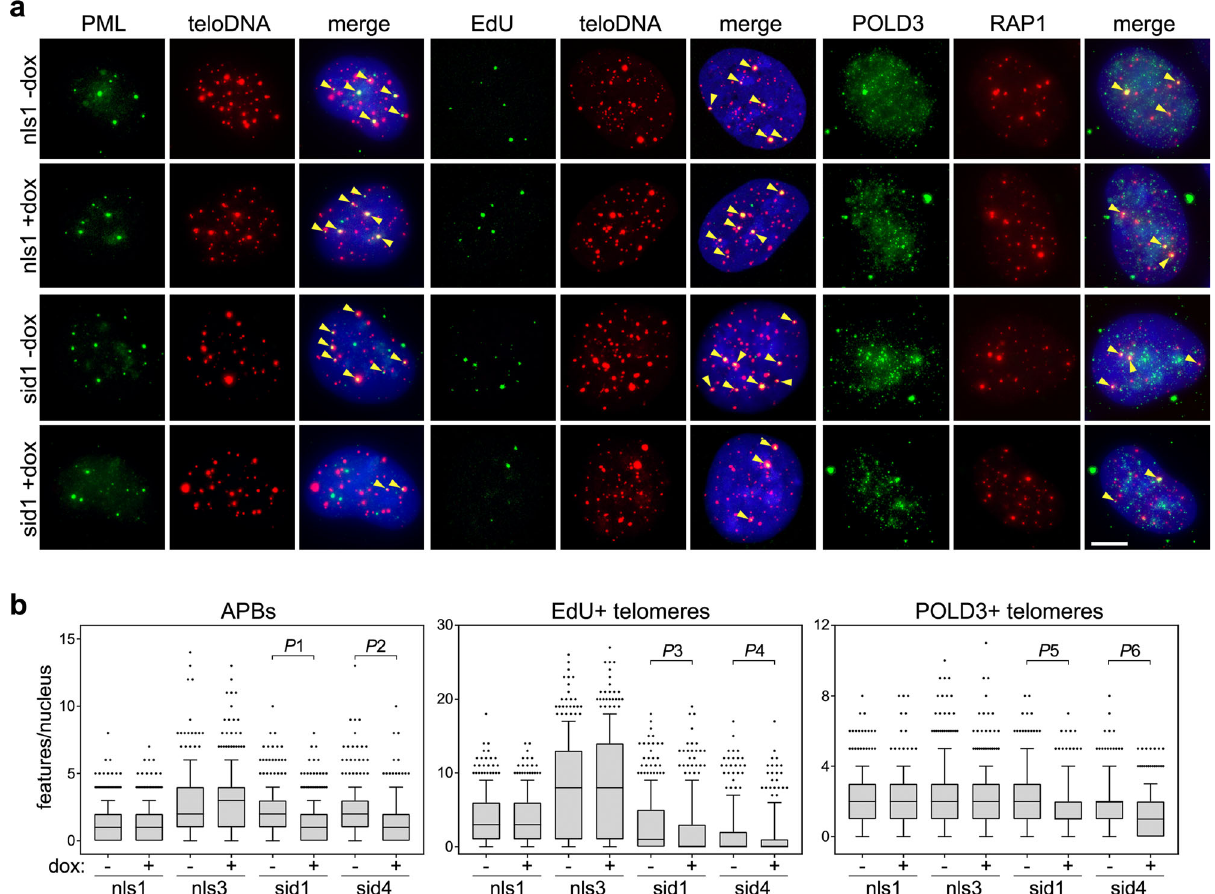
Fig. 3 TERRA transcription inhibition alleviates ALT activity. a Left and right panels: examples of PML or POLD3 IF (green) combined with telomeric DNA FISH (teloDNA) or RAP1 IF (red). Middle panels: examples of EdU detection (green) combined with telomeric DNA FISH (red). DAPI-stained DNA is in blue. The indicated cell lines were treated with dox for 24 h for PML or for 24.5 h for POLD3 and EdU (G2 synchronized cells, see methods for details). Arrowheads in the merge panels point to co-localization events. Scale bar: 5 μ m. b Quanti fi cations of experiments as in a . Boxplots represent the medians (middle lines) and the fi rst and third quartiles (boxes), the whiskers extend to the 90th percentile of the values. A total of at least 300 nuclei from three independent experiments were analyzed for each sample. P -values were calculated with a two-tailed Mann – Whitney U test. P 1 = 0.0169; P 2 < 0.0001; P 3 = 0.0193; P4 = 0.0812; P 5 < 0.0001; P 6 = 0.0063. Source data are provided as a Source Data fi